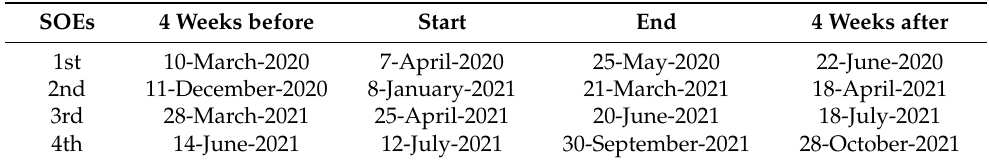
Table 1. SOE periods during 2020–2021 for Tokyo.